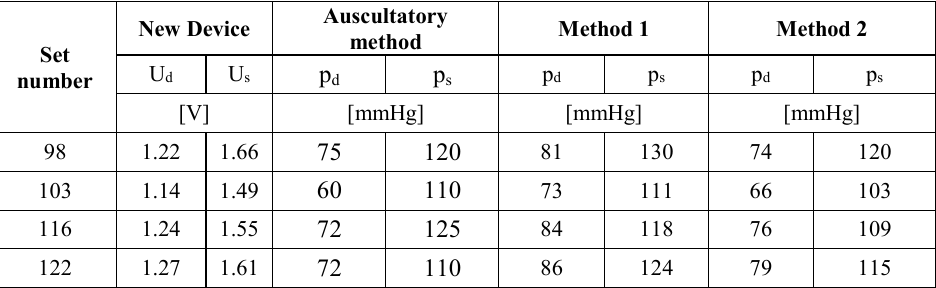
Table 2. Obtained data sets and calculated coefficients.